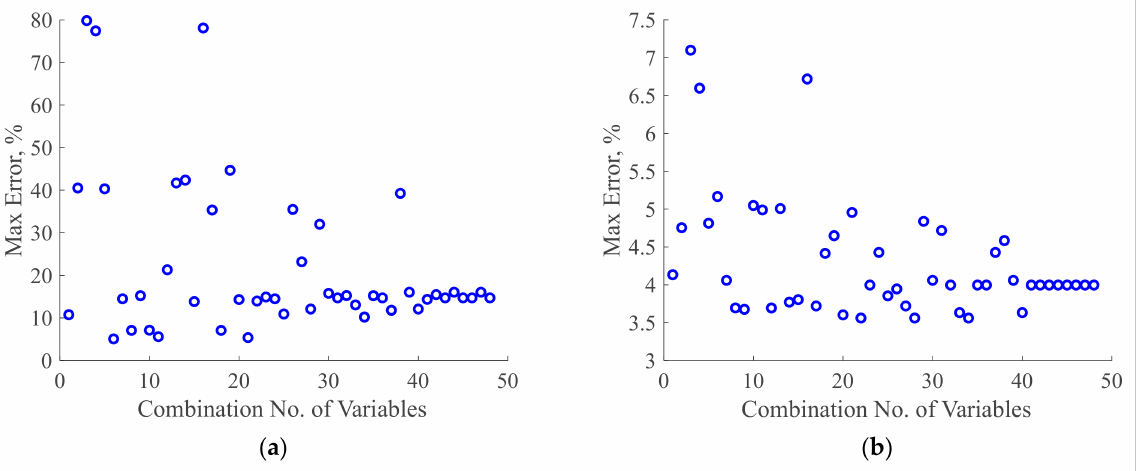
Figure 7. Average of maximum percentage errors presented for outer pitot probes (nos. 44 and 45) for all measured flight cases ( a ) without RSM-based interpolation and ( b ) with RSM-based